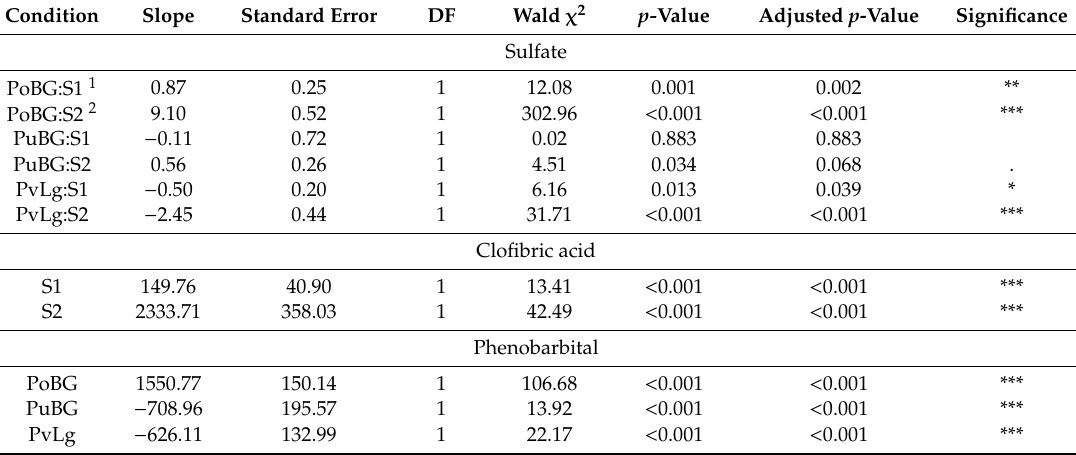
Table 2. Outputs of the e ff ect size and significance of sulfate, clofibric acid, and phenobarbital on alpha diversity within location and season, season, or location. The e ff ect size is represented as the slope. p -values were adjusted for multiple testing with the Holm–Bonferroni test, (* p ≤ 0.05; ** p ≤ 0.01; *** p ≤ 0.001; . not statistically significant).